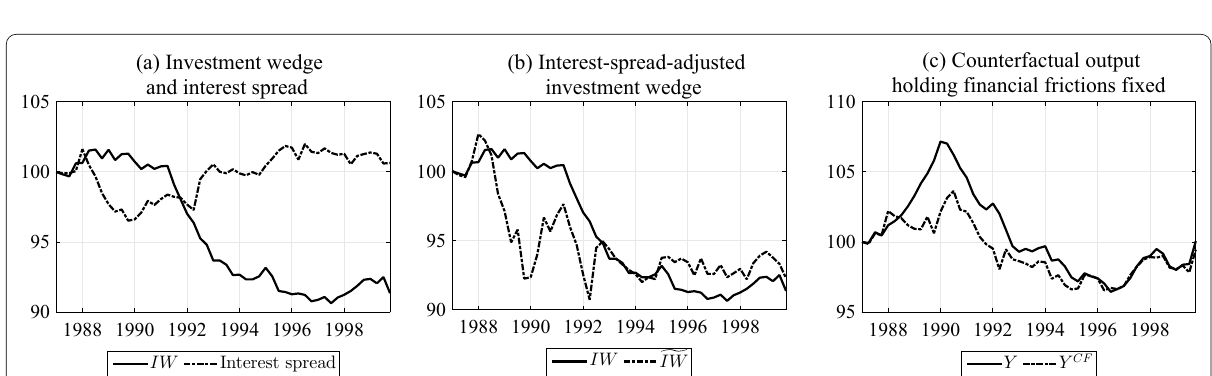
Fig. 22 Robustness: The role of disruptions in financial intermediation for µ = 0.20 (1987Q1–1999Q4). IW denotes the investment wedge, the interest spread corresponds to the spread between the lending and deposit rates obtained from the IMF International Financial Statistics, and is the interest-spread-adjusted investment wedge. Y is output and Y CF denotes the counterfactual path of output when holding financial frictions fixed